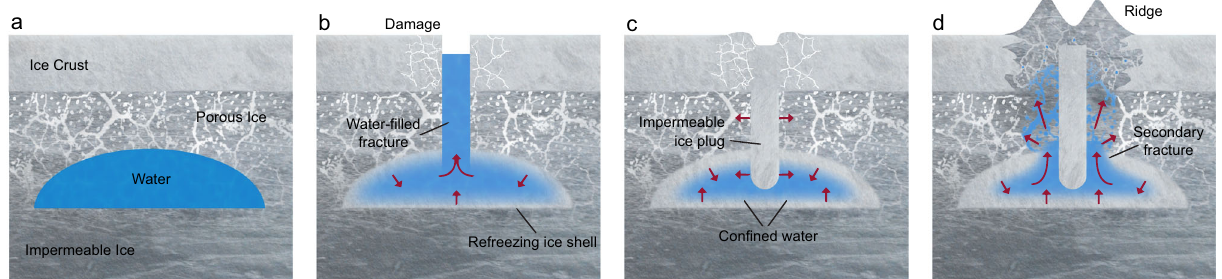
Fig. 4 Double ridge formation mechanism (not to scale). Gray areas are ice, white/light gray shows pore space, and blue areas are liquid water. Red arrows show the direction of forces acting on the sill and the direction of water fl ow if relevant. a Stage 1 — sill emplacement. In Greenland, this likely occurs through concentrated drainage of surface meltwater 41 . On Europa, sills might form by direct injection from the subsurface ocean 27,29,43 , from melting over rising diapirs 32,44 , or through shear heating 26,30 . b Stage 2 — the sill fractures due to internal overpressure or other near-surface stresses and water fi lls the central conduit. c Stage 3 — the sill is divided by refreezing within the central conduit or fracture network. d Stage 4 — a double ridge develops as overpressurized water within the refreezing sill is forced out along the planes of weakness fl anking the refrozen central conduit, producing the symmetric surface